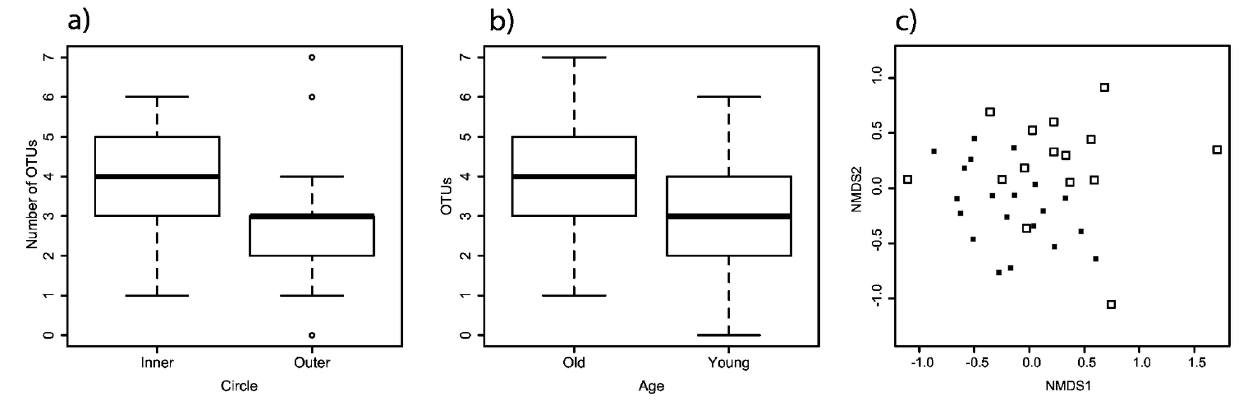
Figure 2. Boxplots showing ectomycorrhizal (EM) fungal diversity recovered from 48 individual ingrowth bags collected around six isolated Pinus muricata trees of two different ages. a) More EM OTUs in inner compared to outer circle ( P < 0.05). b) More EM OTUs associated with old trees ( P < 0.05). c) NMDS ordination based on OTUs presence/absence; each point represents an individual ingrowth bag, open squares are ingrowth bags from old trees, and closed squares are bags from young trees (stress = 0.1).